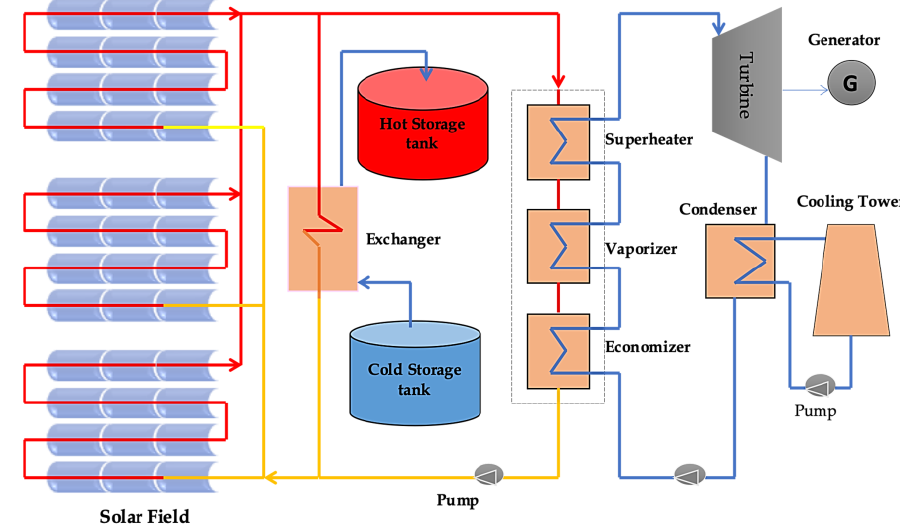
Figure 1. Schematic diagram of the PTC plant model [22]. Table 1. Description of parameters for different various SCAs .